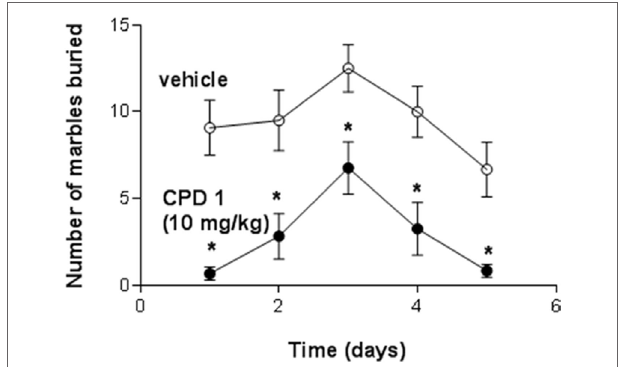
FigUre 9 | effects if cPD1 on marble-burying behavior of mice over five consecutive days . Marble-burying was significantly decreased by CPD 1 (10 mg/kg) compared to vehicle-treated mice ( F 1,110 = 59.4, p < 0.0001). There was also a significant impact of dosing day ( F 4,110 = 5.2, p < 0.001) but no significant day × treatment interaction ( F 4,110 = 0.31, p = 0.87). Data are means ± SEM of 12 mice/group. * p < 0.05 compared to day 1 (Dunnett’s test).